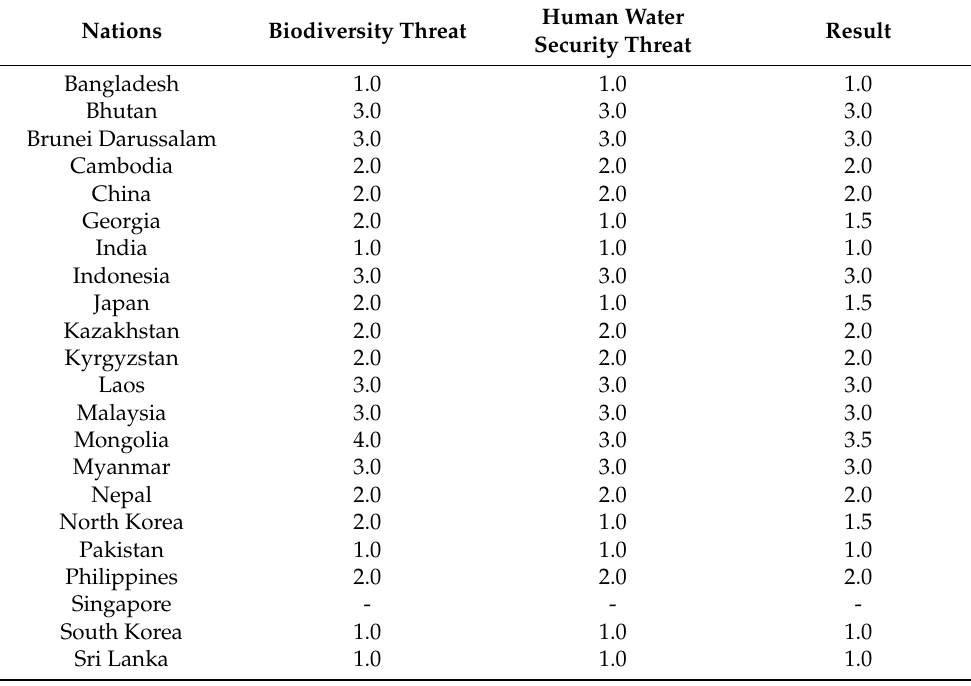
Table 10. Assessment result of environmental